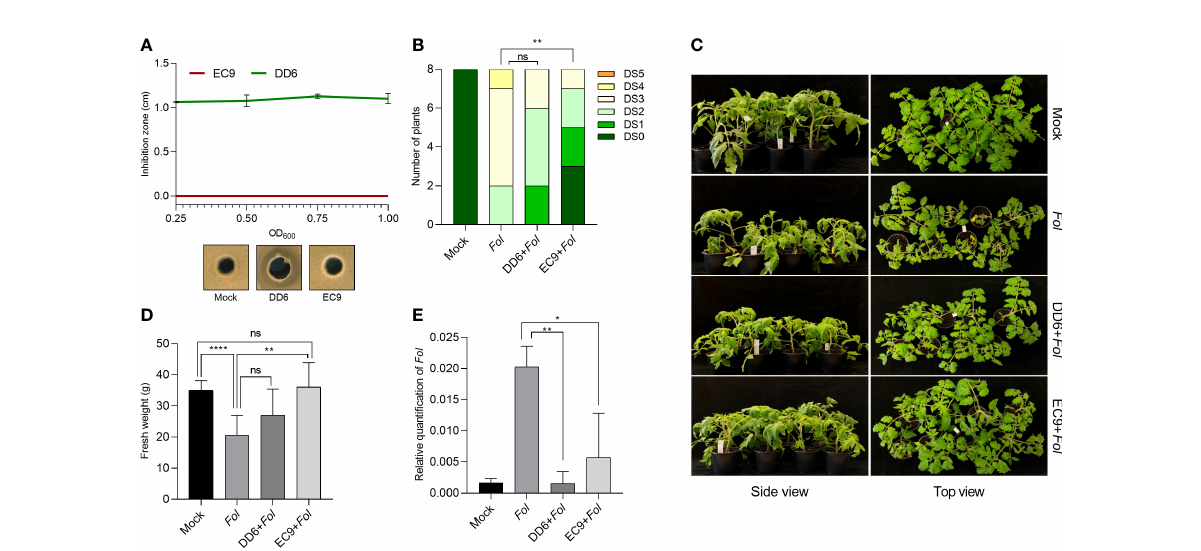
FIGURE 1 Treatment with B cereus EC9 enhances resistance to Fusarium wilt in tomato. (A) Inhibition zones caused by Bacillus spp. against Fol on PDA medium. The antifungal activity was determined after 5 days of incubation (n=5). (B) Disease severity score, (C) representative pictures of disease symptoms, and (D) fresh weight of tomato plants (cv. Moneymaker) at 21 days post-inoculation (dpi) (n=8). Ten days old tomato seedlings were treated with DD6, EC9 or 10 mM MgCl 2 (mock) by soil drenching and inoculated with Fol 1 week after treatment. (E) Estimation in planta (n=4) of Fol biomass in tomato stems. Quanti fi cation of Fol was carried out in plants at 21 dpi by calculating the ratio of fungal DNA to tomato DNA by qPCR. ns non-signi fi cant, * P < 0.05, ** P < 0.01, **** P < 0.0001. The experiments were repeated at least two times with similar results. Bars represent the means of the indicated number of biological replicates ± standard